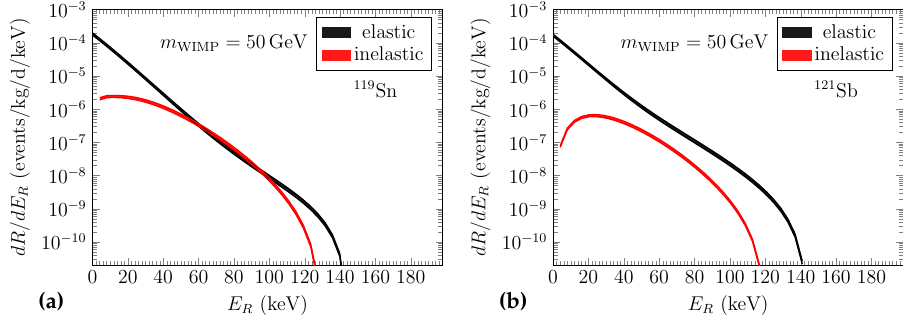
Figure 6. Differential event rates for WIMPs of mass 50 GeV: ( a ) in 119 Sn and ( b ) in 121